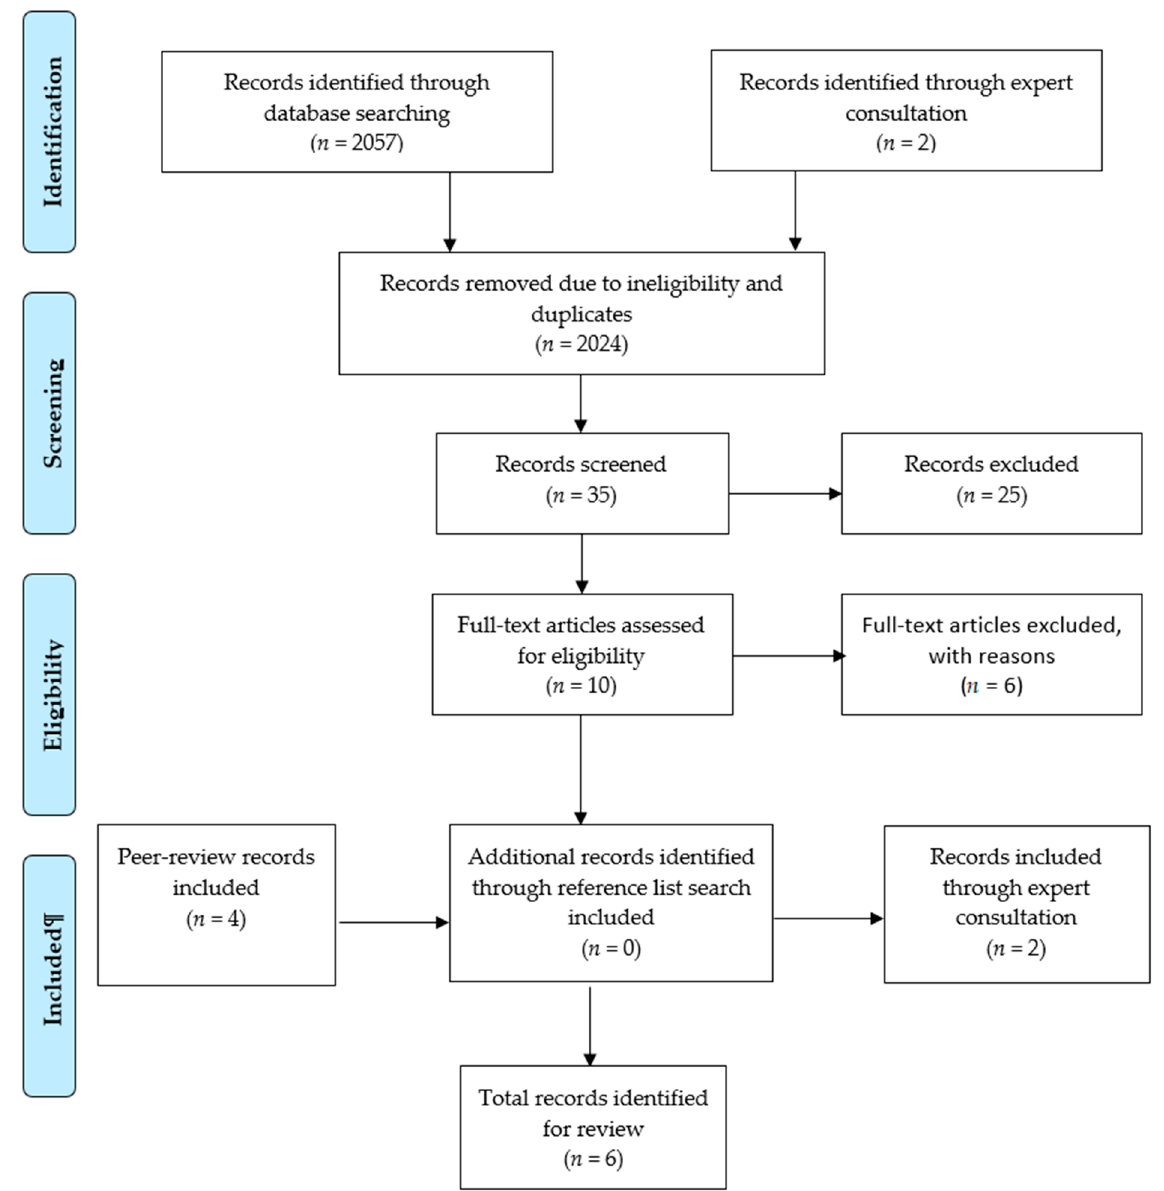
Figure 2. PRISMA study selection flow chart regarding parents of CWD. Table 4. Literature regarding the development of physical activity messages targeting parents of children with disabilities.